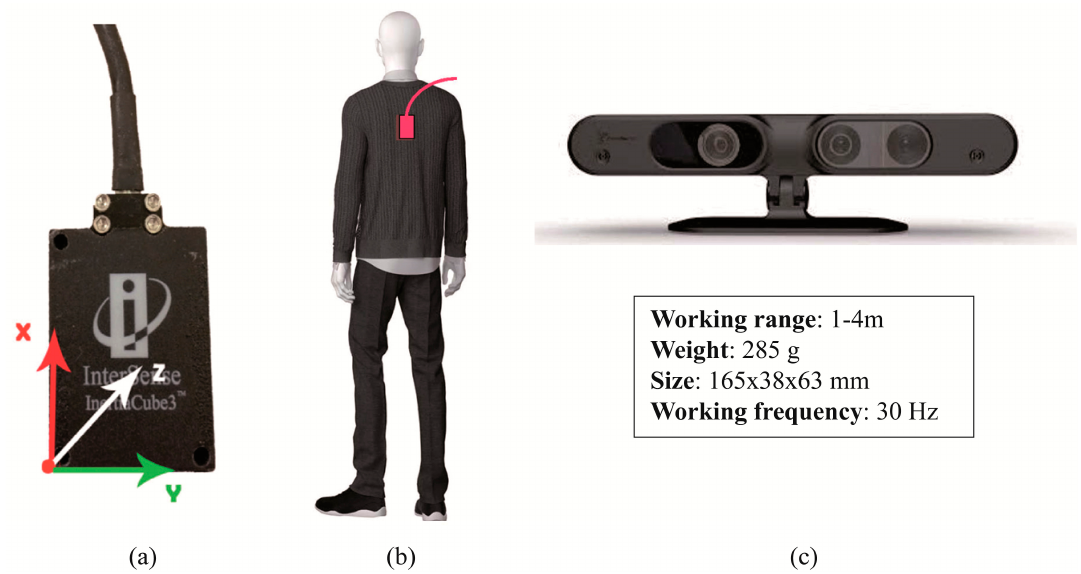
Figure 1. ( a ) Axes orientation of the inertial sensor and ( b ) its position on the participant’s body. ( c ) PrimeSense’s RGB-D camera and its main characteristics. ( c ) PrimeSense’s RGB-D camera and its main